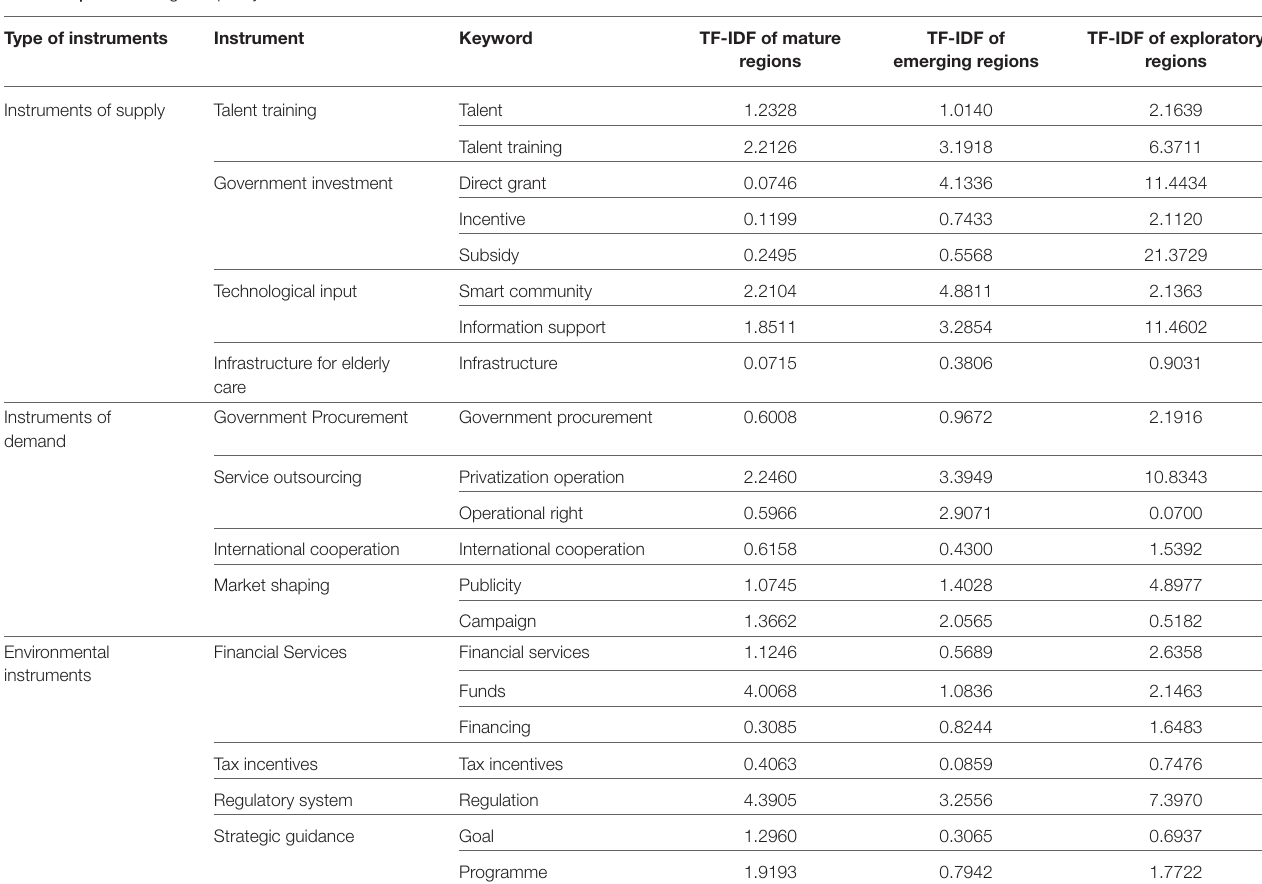
TABLE 3 | TF-IDF weight of policy instruments in Phase